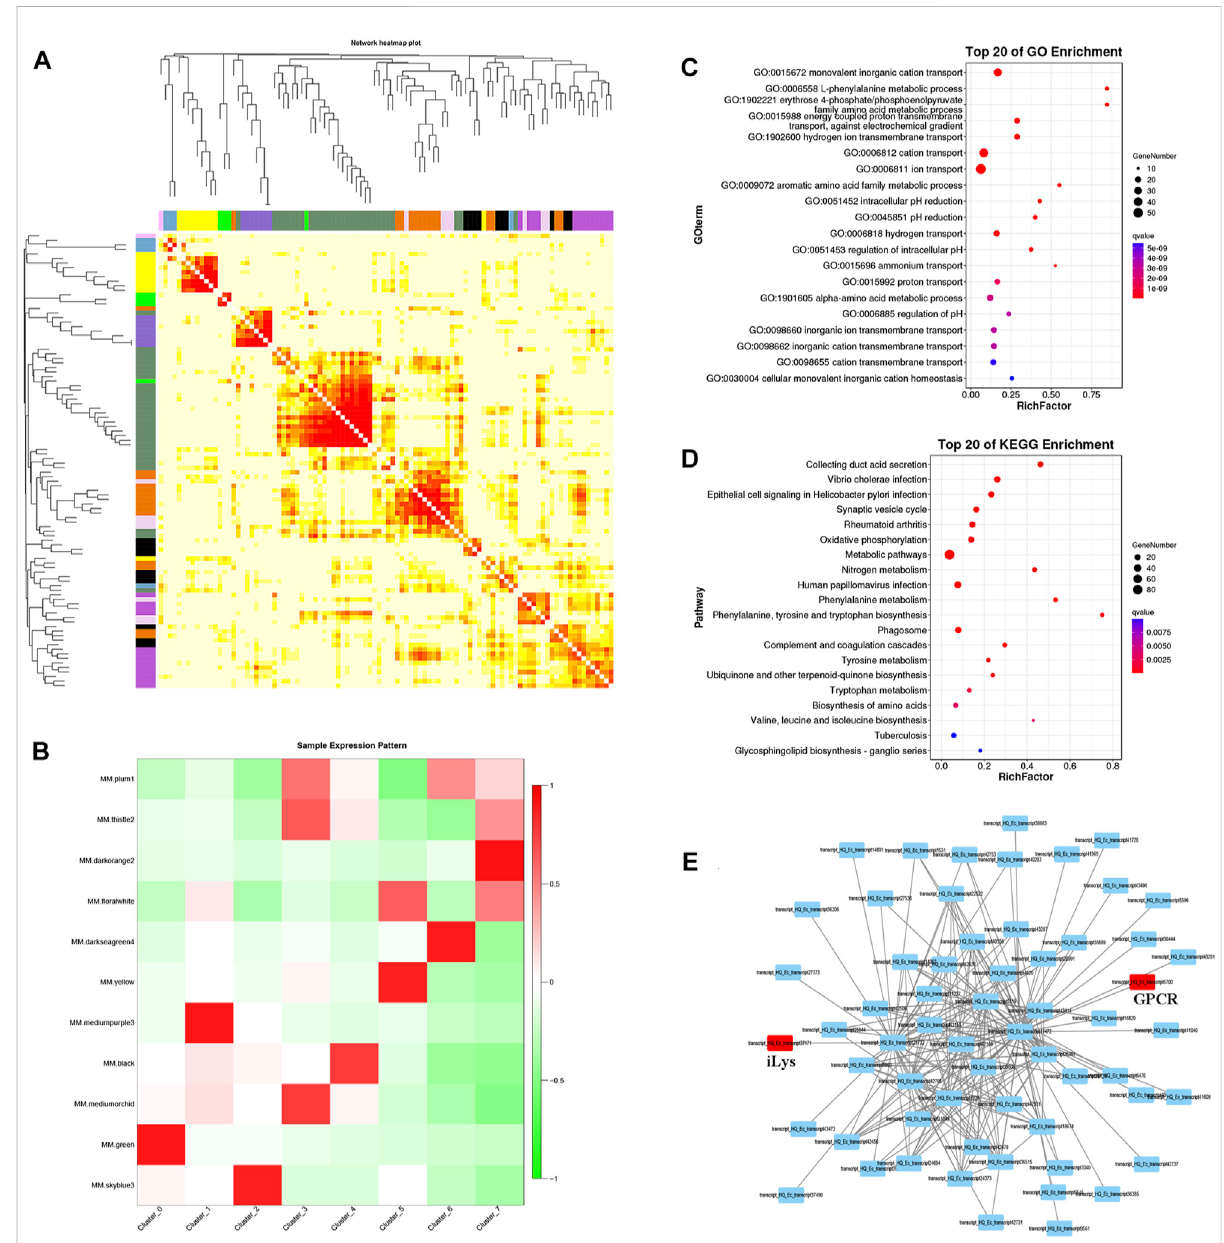
FIGURE 6 WGCNAanalysisofpillarcellpopulation. (A) Clusterthegenesinthemoduleandarrangetheheatmap.Eachrowandcolumnrepresentagene, andthedarkerthecolorofeachpointrepresentsthegreatertheconnectivitybetweenthetwogenescorrespondingtotherowandcolumn. (B) The heat map of sample expression pattern. Red represents high expression and green represents low expression. (C) GO enrichment of green module. (D) KEGG enrichment of green module. (E) Single-cell transcriptional networks inference of green module based on top 200 relationship gene